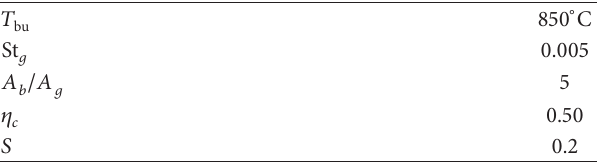
Table 3: Parameters assumed in the cooling